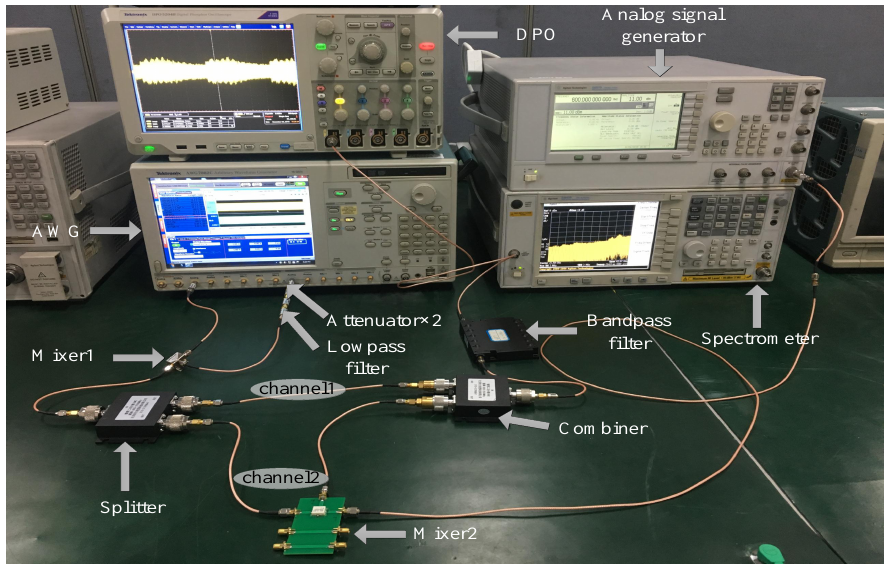
Figure 10. Hardware testing for the novel single-channel CTS structure.